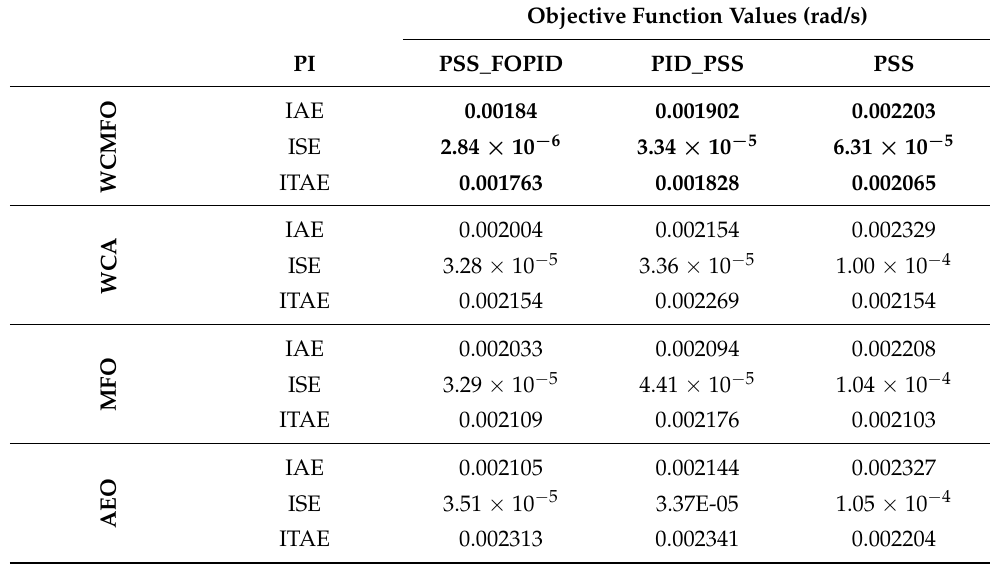
Table 4. Optimal objective function values.